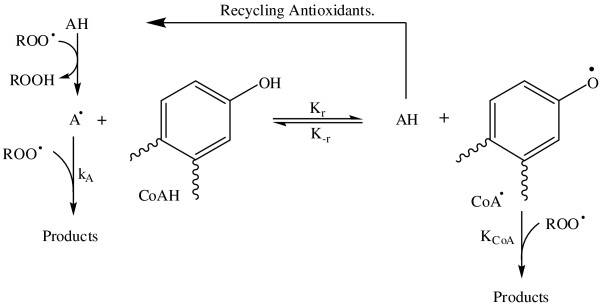
Co-antioxidant effectively recycles antioxidant. AH = antioxidants, α-TOH; CoAH = co-antioxidant.